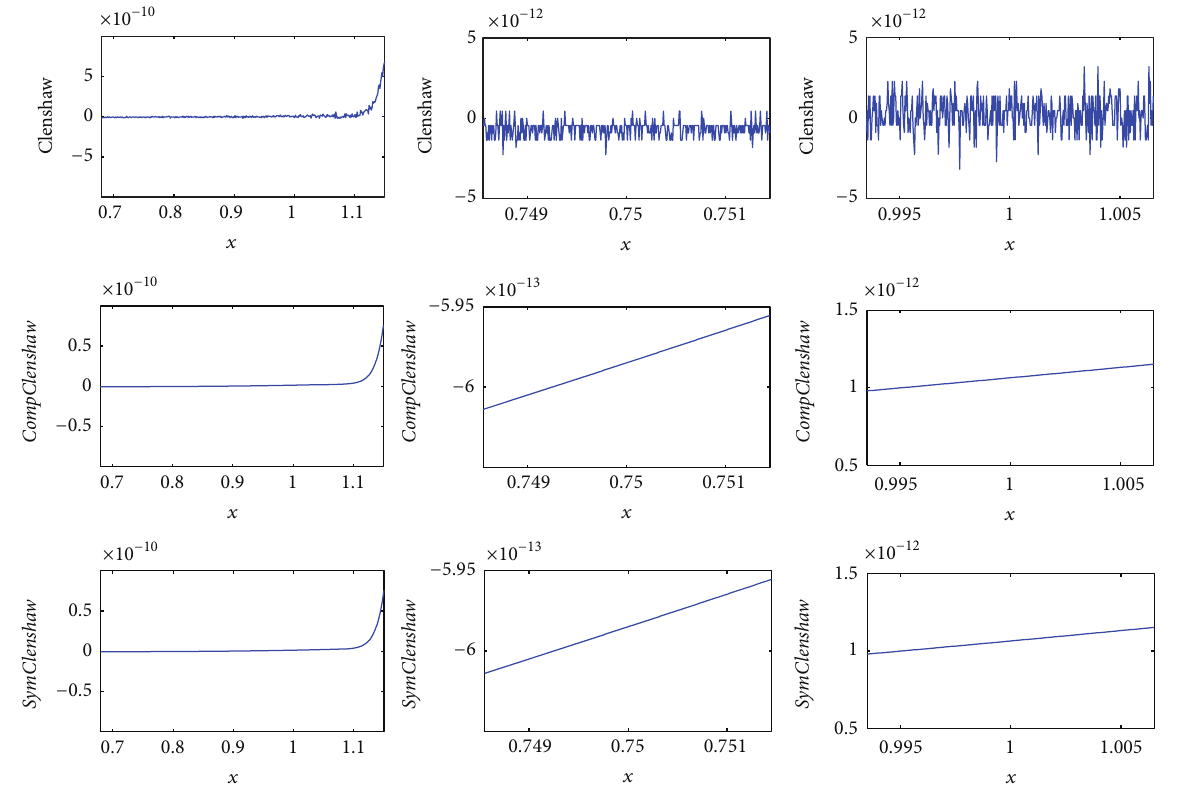
Figure1:Evaluationofpolynomialconvertedfrom 𝑝(𝑥) = (𝑥−0.75) 7 (𝑥−1) 11 bythe 𝐶𝑜𝑛 V 𝑒𝑟𝑡 algorithminLegendrebasisintheneighborhood of its multiple roots, using the Clenshaw algorithm (up), the 𝐶𝑜𝑚𝑝𝐶𝑙𝑒𝑛𝑠ℎ𝑎𝑤 algorithm (middle), and Symbolic Toolbox